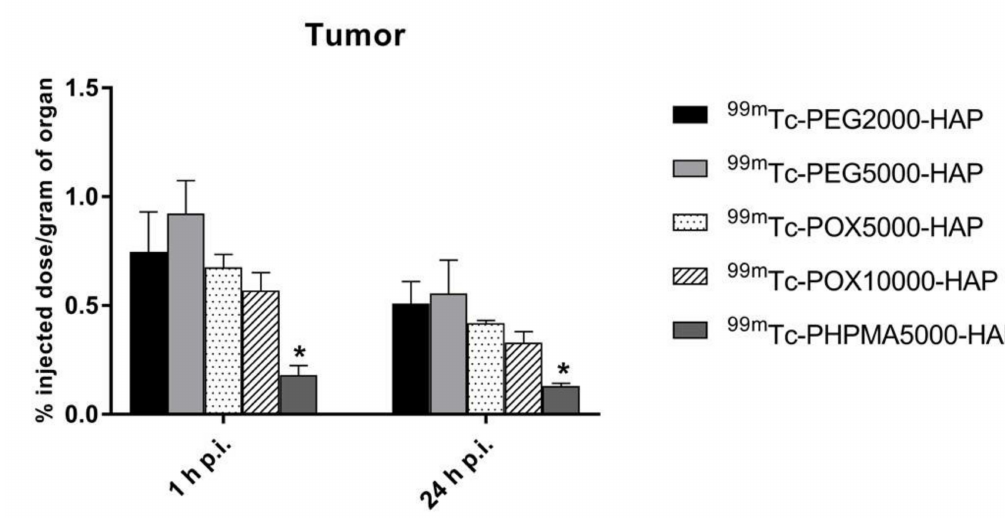
Figure 6. Uptake of 99m Tc-PEG2000-HAP, 99m Tc-PEG5000-HAP, 99m Tc-POX5000-HAP, ( n = 3 animals per time point). * indicates statistical di ff erence ( p <